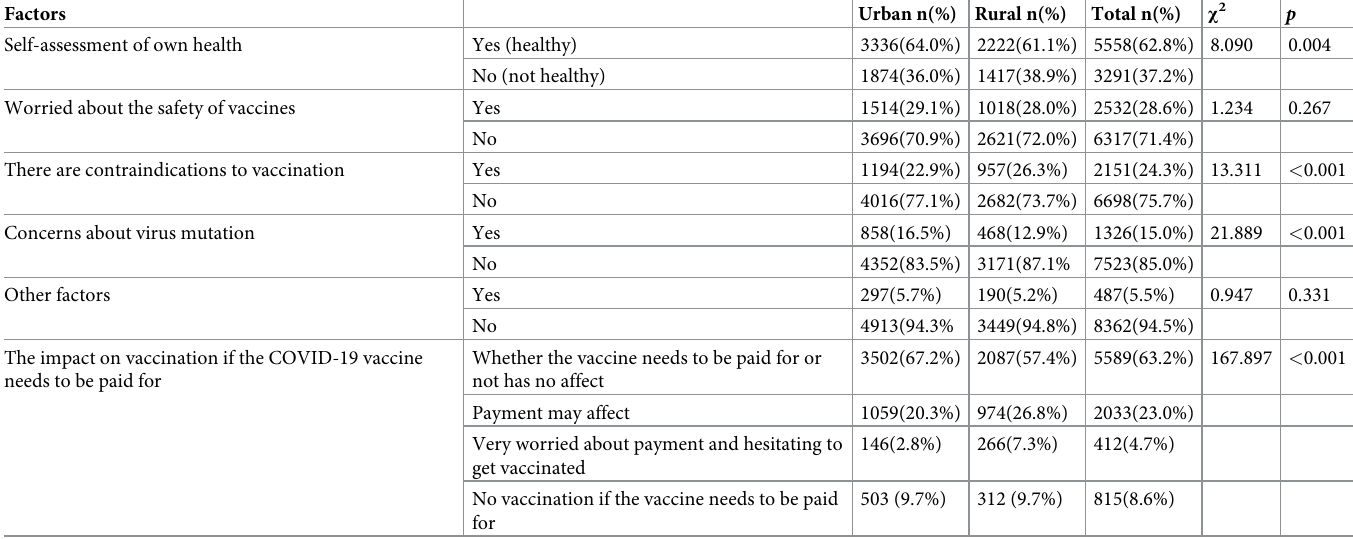
Table 2. Comparison of urban-rural differences in related factors affecting COVID-19 vaccination (n = 8849).